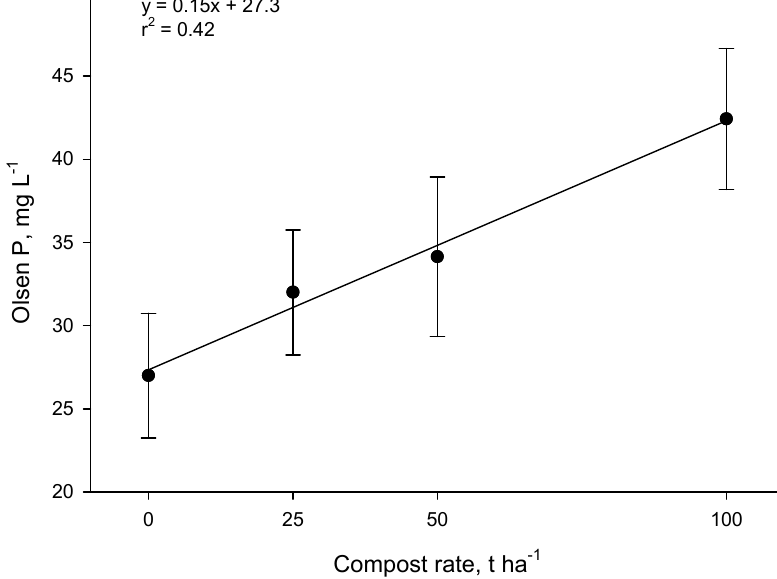
Figure 7. Relationship between Olsen P (0–15 cm) and compost application rate for the Forage trial (Olsen P measured in November 2008, 1 year after compost application). The error bars represent 95% confidence intervals.